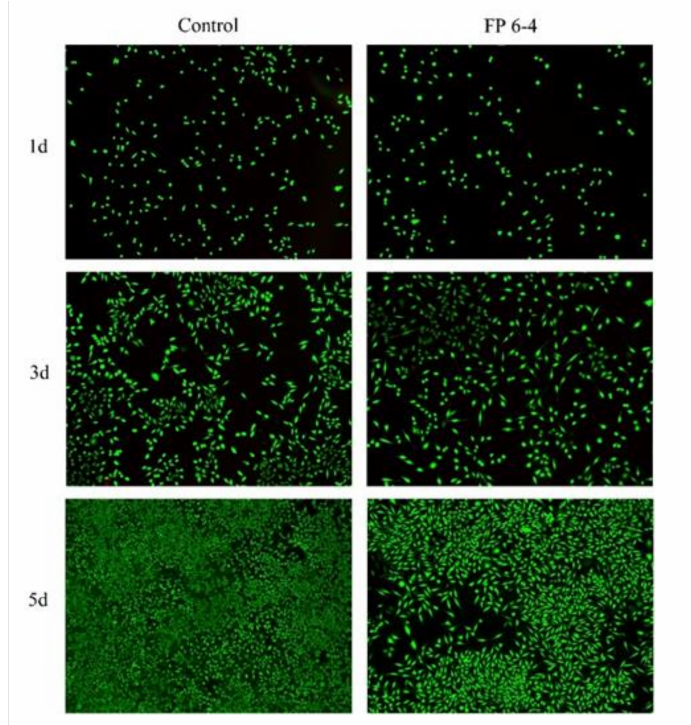
Figure 8. AMPI staining (green for living cells, red for dead cells).